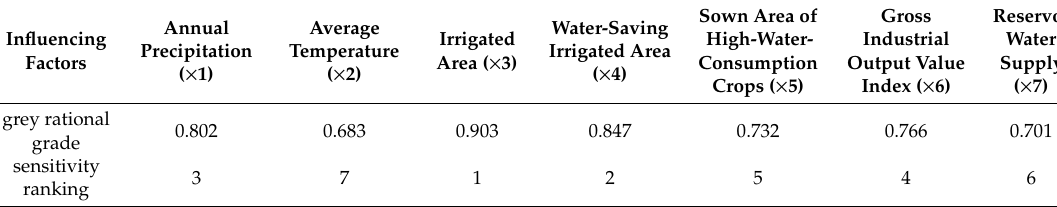
Table 2. Sensitivity of groundwater level to the influencing factors with GRA